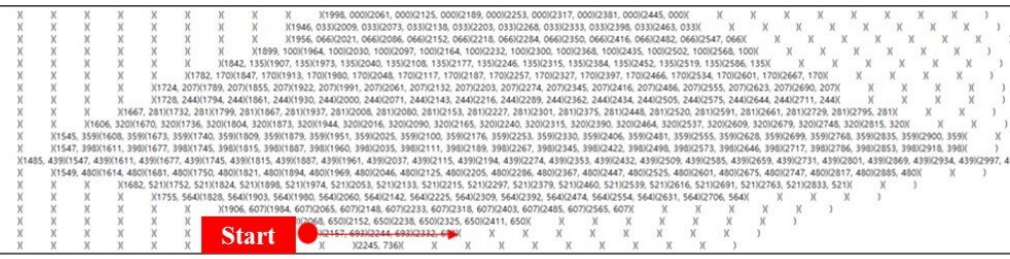
Figure 7. Setting up image-taking area coordinates for the ship block